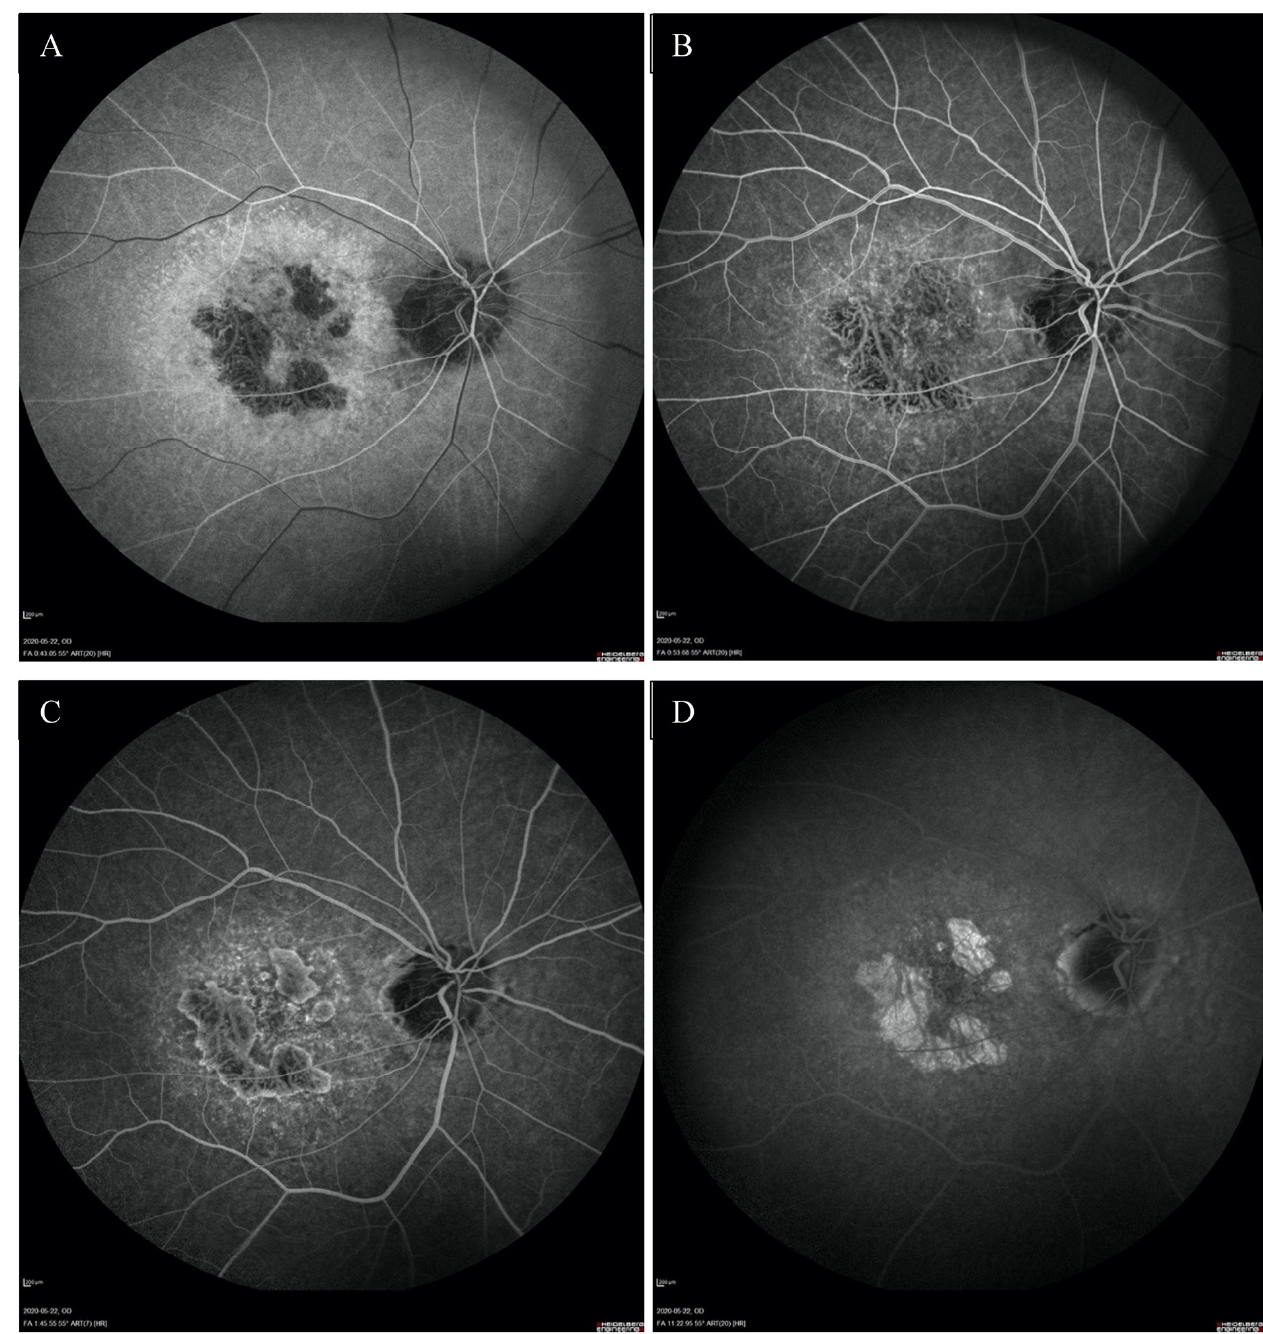
Figure 4. FFA of the right eye ( A – D ) revealed the presence of granular hyperfluorescence in the macular and concomitant areas of capillary atrophy.